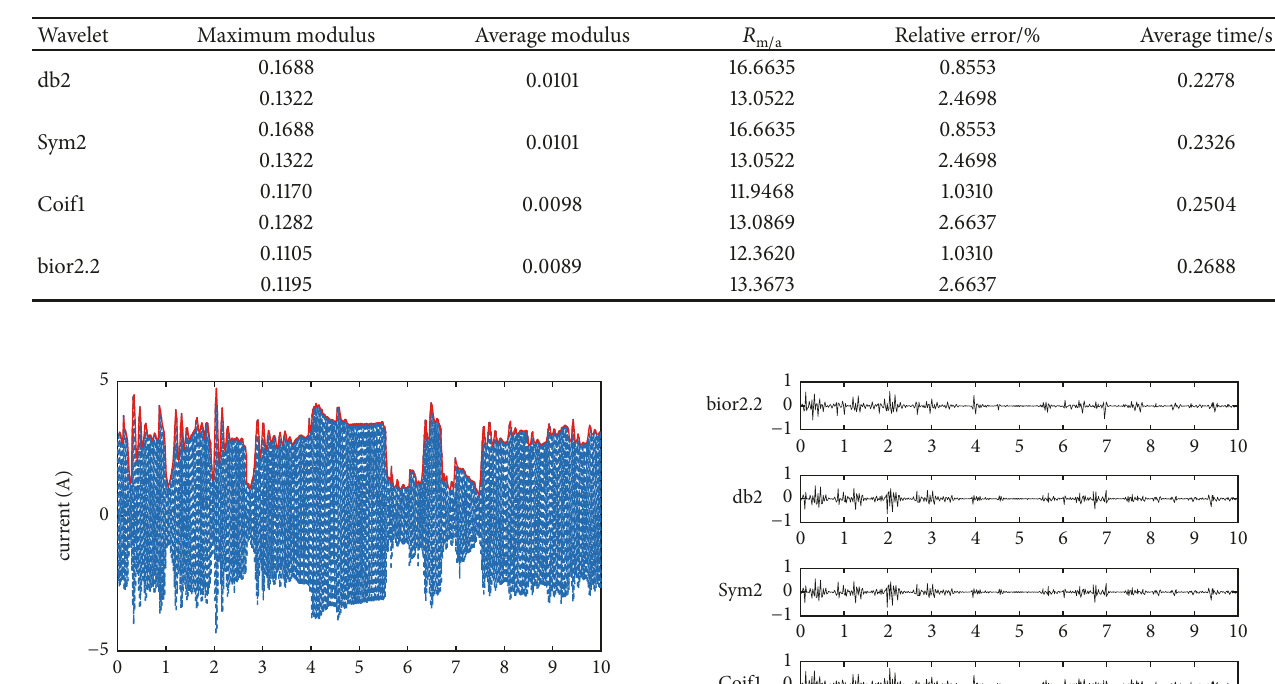
Table 7: Comparison of envelope method with different wavelets.